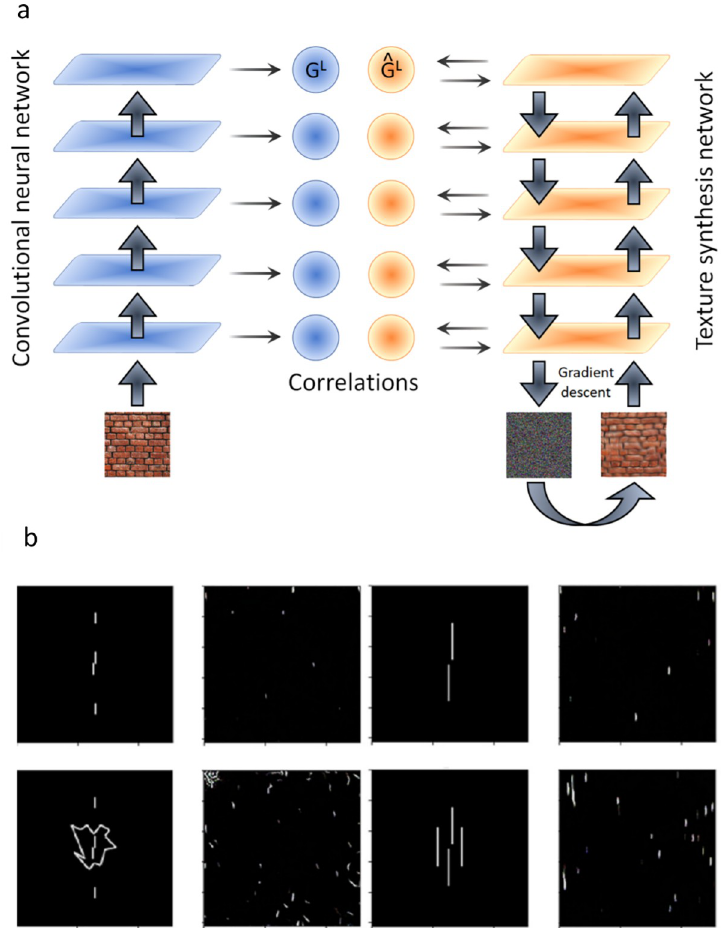
Fig 7. Deep textures. a. In the deep textures algorithm, the correlation between a deep neural network’s unit activities is used as a summary statistic. Textures are then synthesized to match that statistic. b. Original stimuli and textures synthesized from these stimuli using the deep textures algorithm by Gatys et al. [35]. The vernier offset is poorly visible, therefore, despite its clear success at synthesizing textures, the model in its present form in not suitable to model crowding with our stimuli. We tried different zooms on our stimuli but the results did not